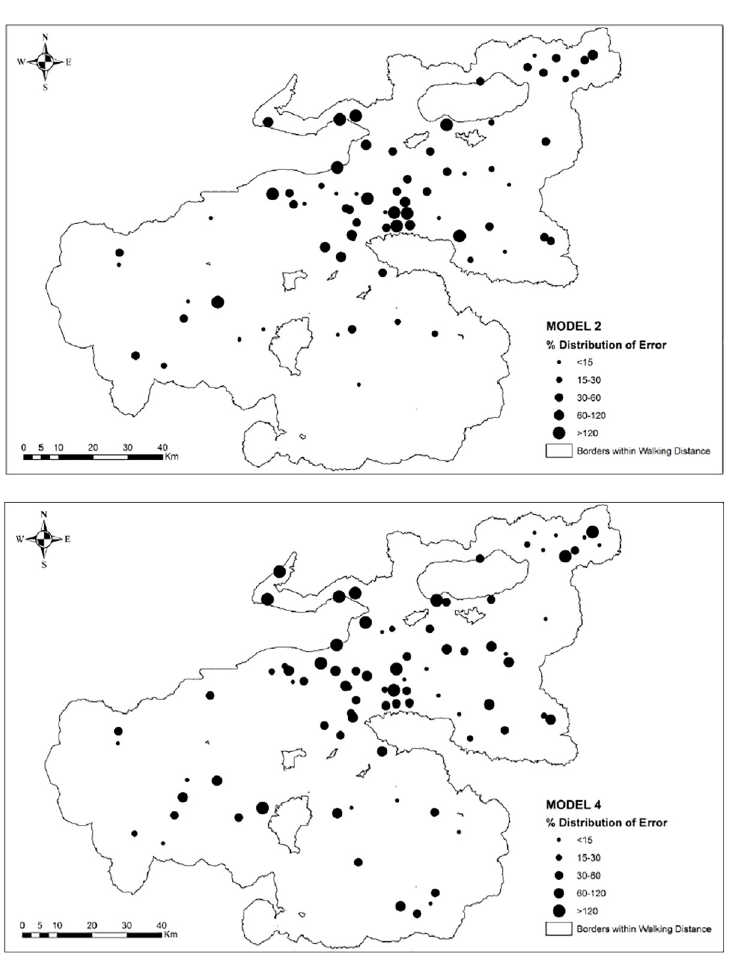
Fig 6. Deviation of predicted values from observed values across different models estimated for Bursa settlements (a) Model 2 (b) Model 4.